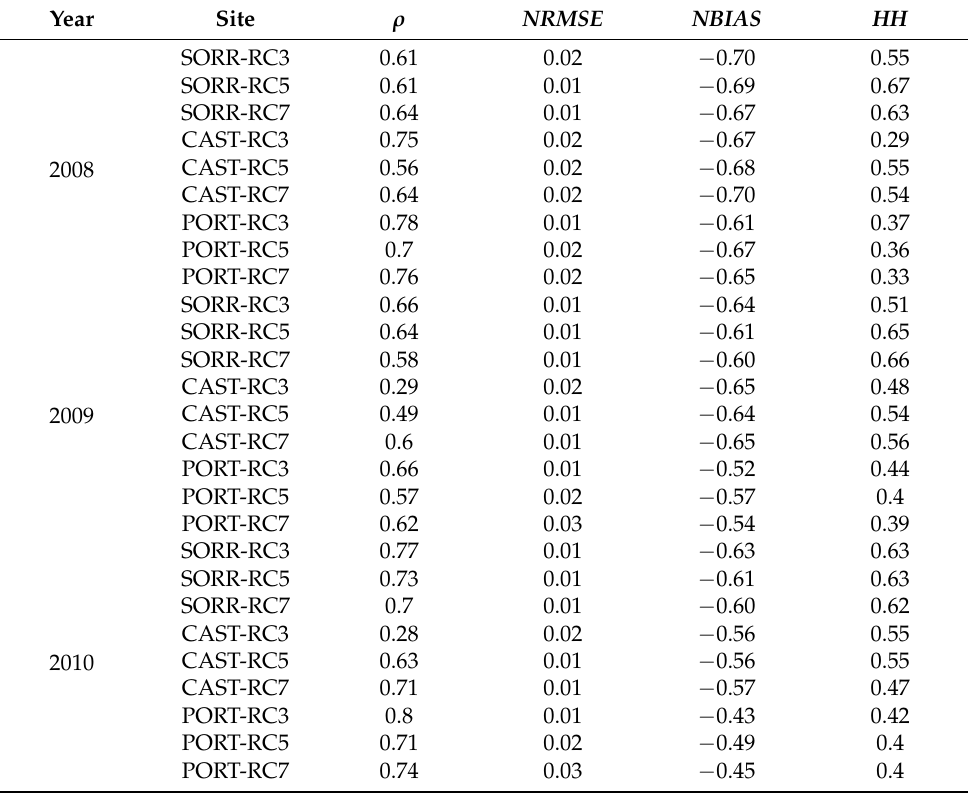
Figure 4. ( left ) Time series comparison of wave heights (Hs) between PORT HFr (blue) and MWM (red) from RC3, RC5 and RC7 (upper, middle and lower panel, respectively). ( right ) Scatter plots of Hs values recorded by the HFr and retrieved by using the MWM model at the three RCs. Table 1. Skill metrics of the comparison between Hs in three RCs (RC3, RC 5 and RC7) and MWM (co-located data) during the period analysis (May 2008–December